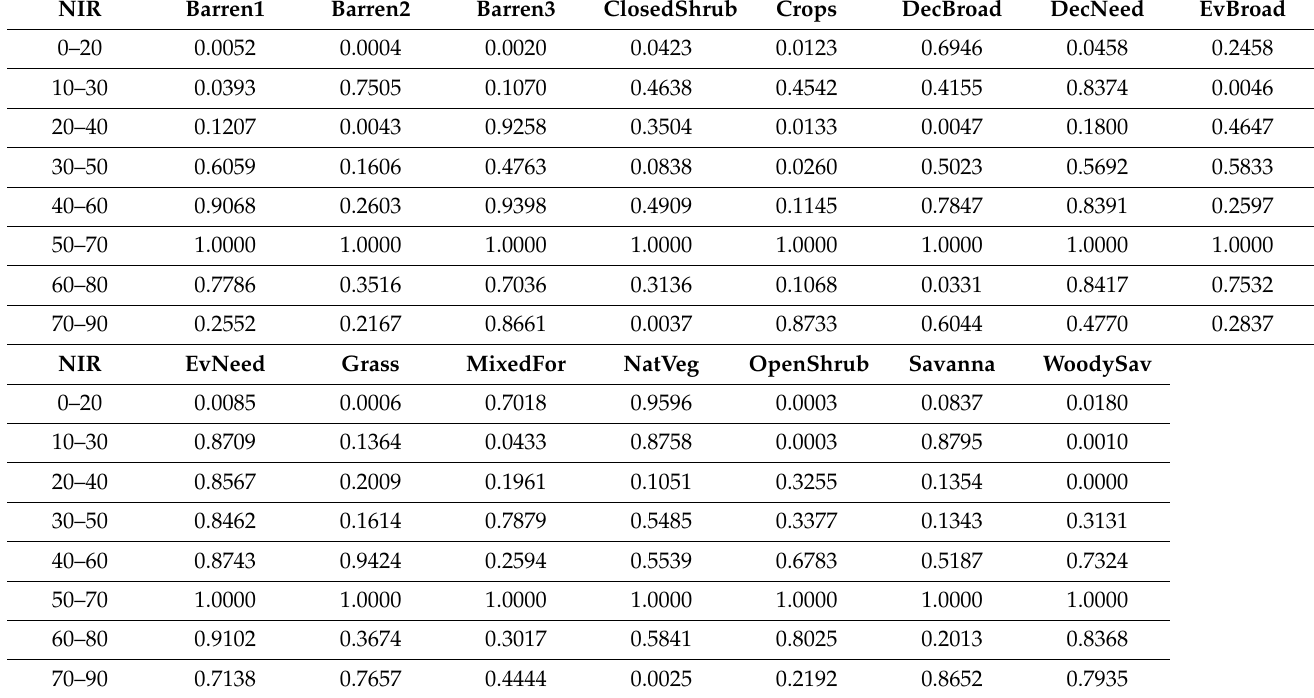
Table A2. NIR band VAAD t -test table. Note that any values less than 0.01, or 1%, are statistically different from the VAAD slice 50 < VAAD < 70. In this case, most slices were viable for analysis, except for 0 < VAAD < 20. This slice is closest to the principal plane, which results in the highest amount of BRDF uncertainty and does not have a lot of samples in the underfly